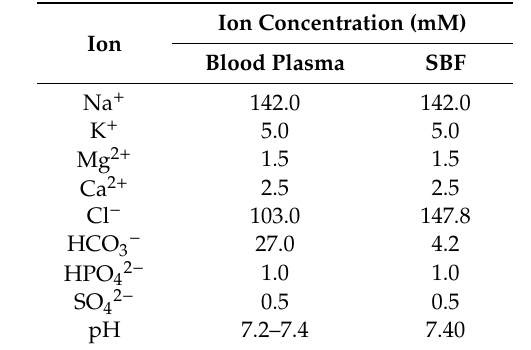
Figure 1. A schematic diagram of the preparation of CHA coatings. Table 1. Nominal ion concentrations of simulated body fluid (SBF) in comparison with those in human blood